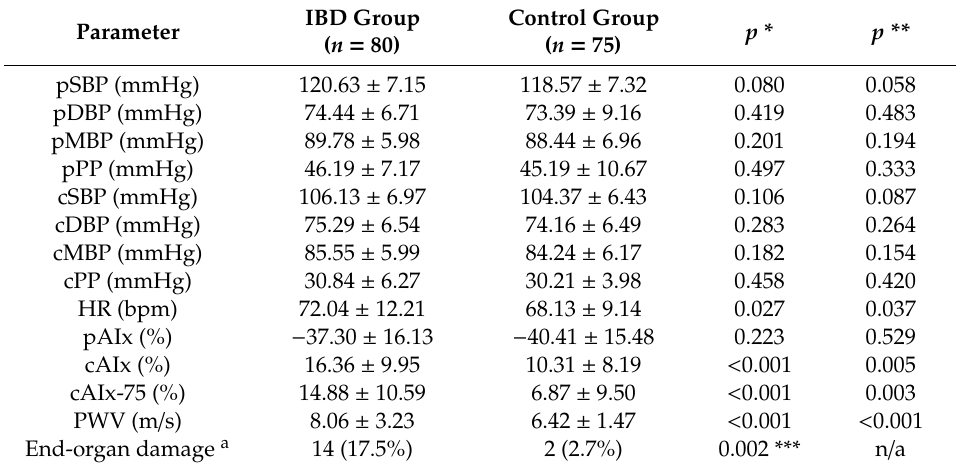
Table 4. Comparison of selected arterial sti ff ness parameters between IBD and control